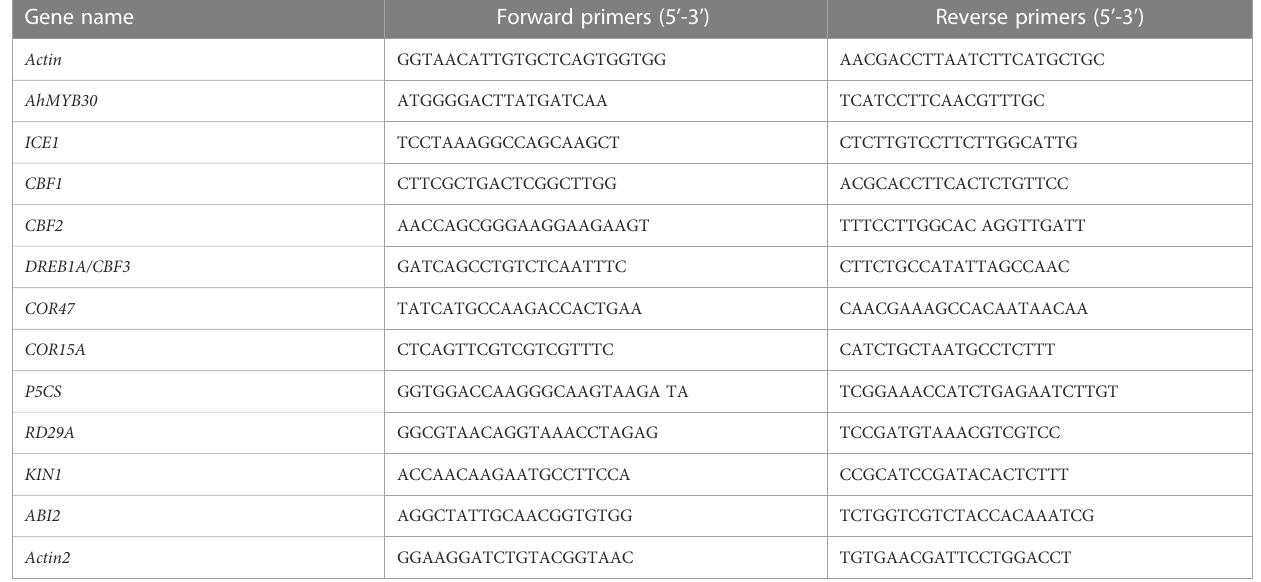
TABLE 1 Primers for fl uorescent quantitative